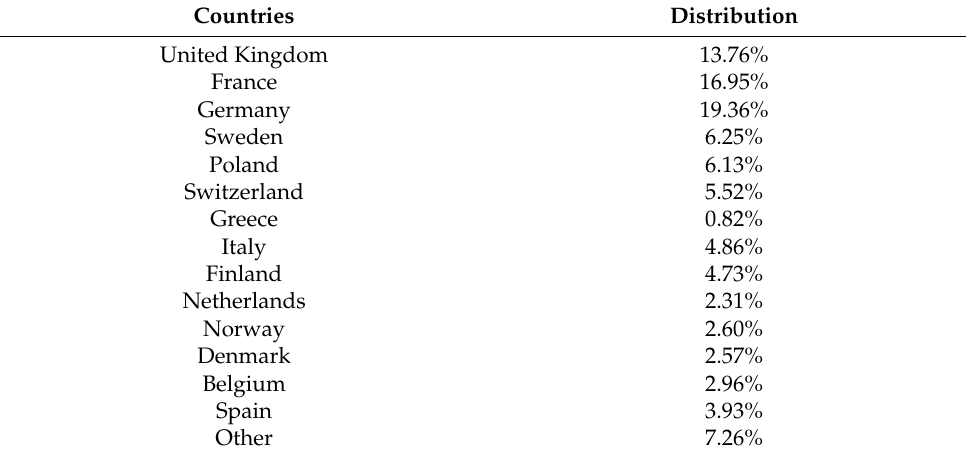
Table 2. Sample distribution in terms of countries.